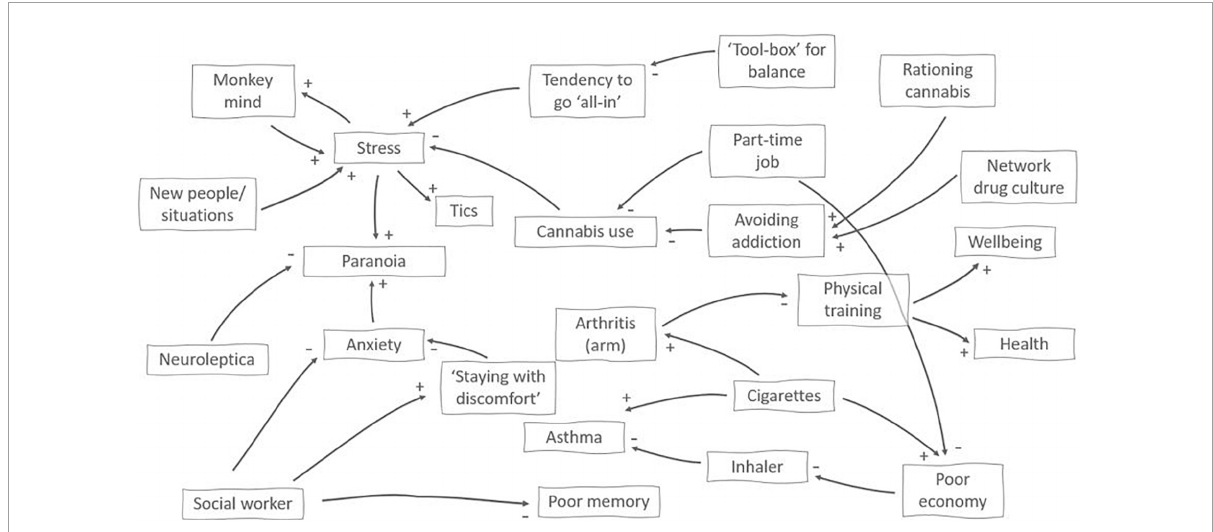
FIGURE3 A network visualization of factors impinging on and contextuaIising cannabis use in a 29-year-old woman diagnosed with paranoid schizophrenia. + or– at the end of an arrow indicates the effects of a change in the originating factor, i.e., new people/situation increases stress, whereas meeting with her social worker helps reduce anxiety. The map was developed in dialog with the participant and used the four categories of factors from the 4E approach ( Figure 1A above) as a